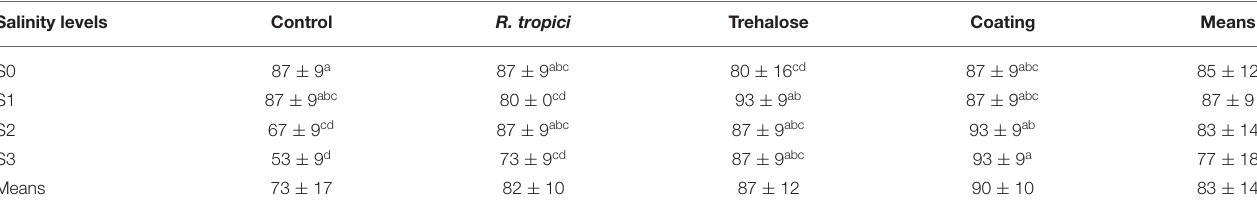
Means 73 ± 17 a − d Different letters indicate significant statistical differences (p < 0.05, Tukey’s